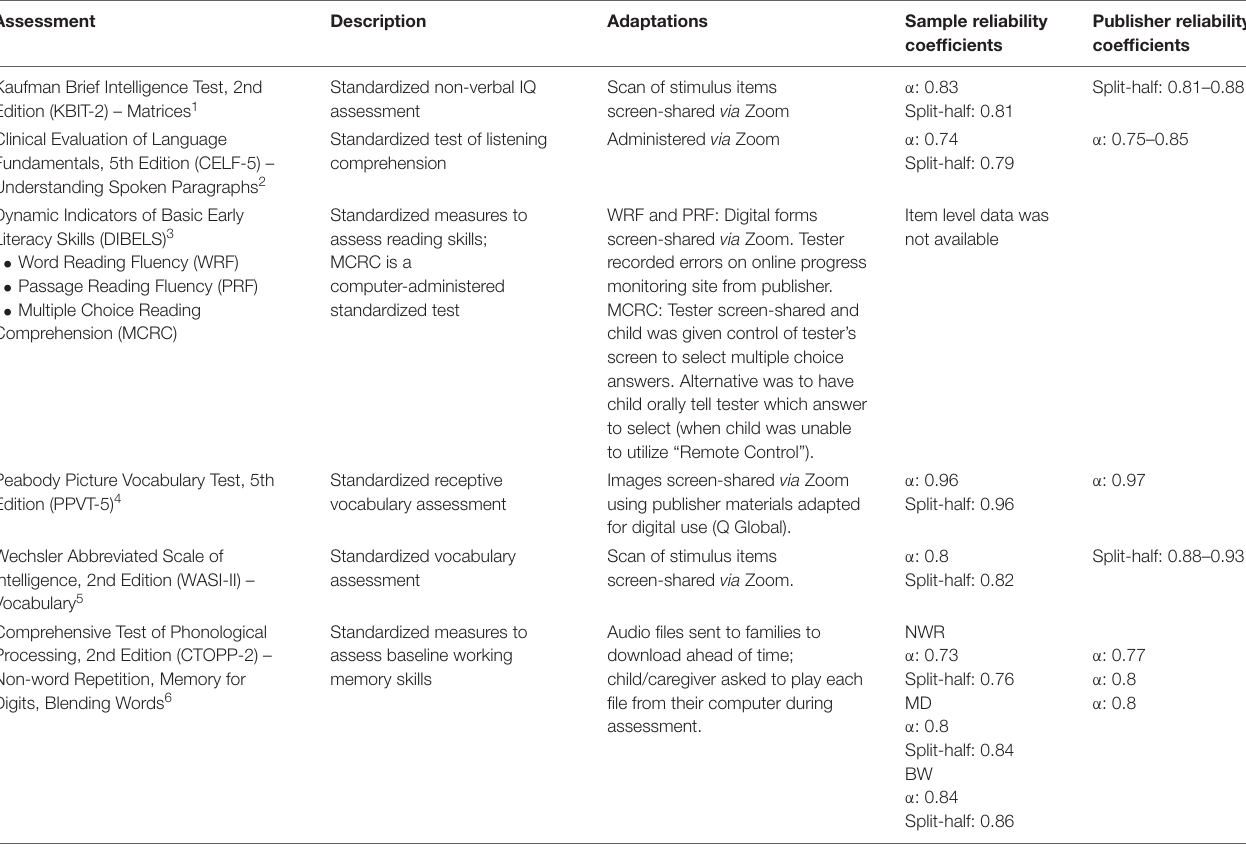
TABLE 4 | Assessments and adaptations for remote